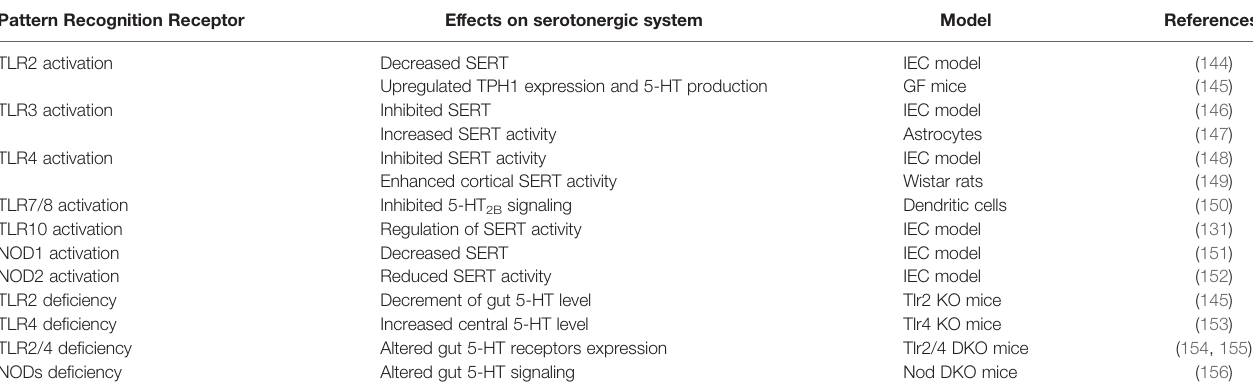
TABLE 3 | Pattern recognition receptors on serotonergic